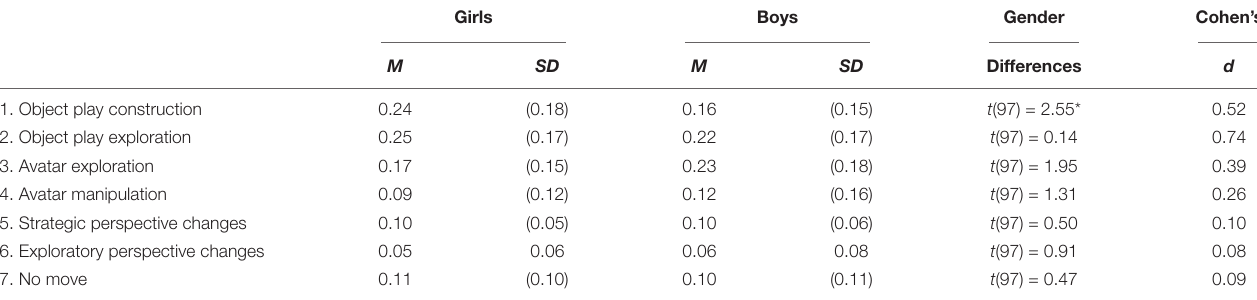
TABLE 5 | Means (and standard deviations) of and gender differences in proportion of Toca Blocks play time children spent engaging in each type of play